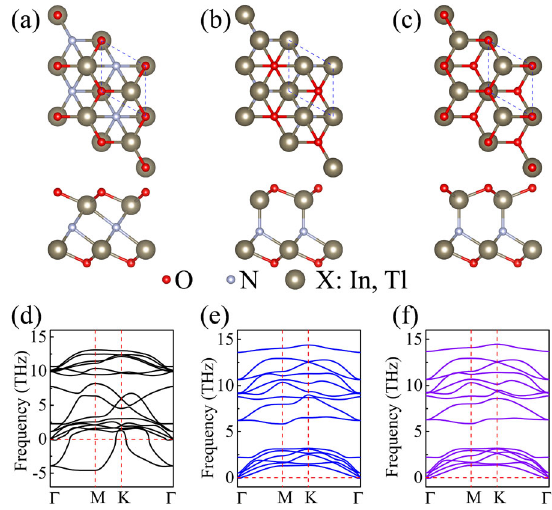
Fig. 1 Crystal structures and dynamic stability. Top and side views of X 2 NO 2 monolayer with ( a ) fcc, ( b ) FE-ZB ′ and ( c ) FE − WZ ′ phase (dashed lines denote a unit cell). The phonon spectra of Tl 2 NO 2 monolayer with ( d ) fcc, ( e ) FE-ZB ′ and ( f ) FE − WZ ′